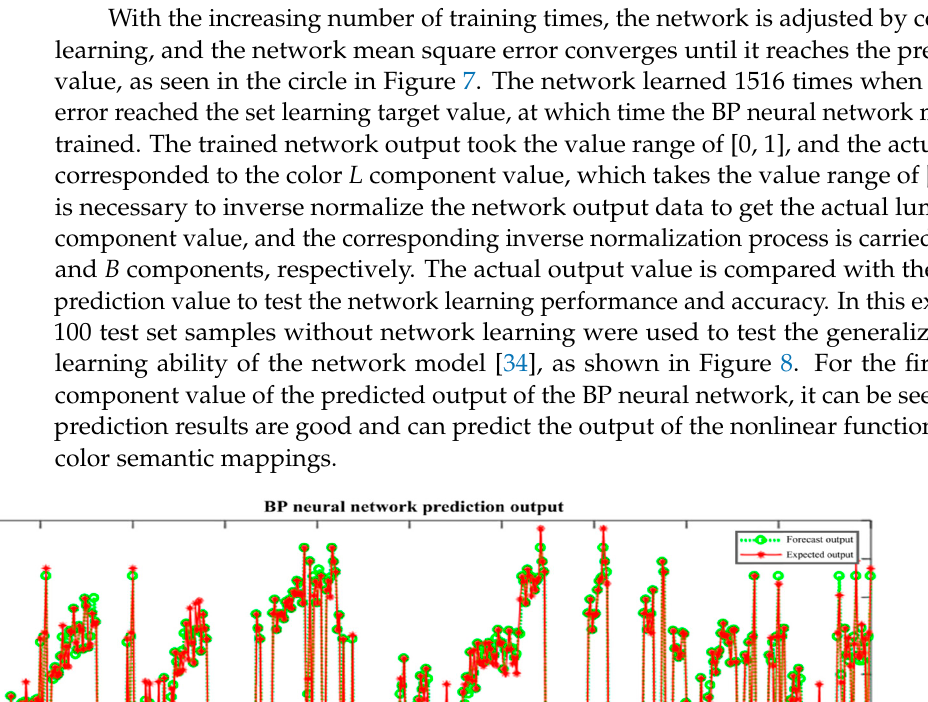
Figure 7. Learning process curve of the network model of complex color perceptual mapping.